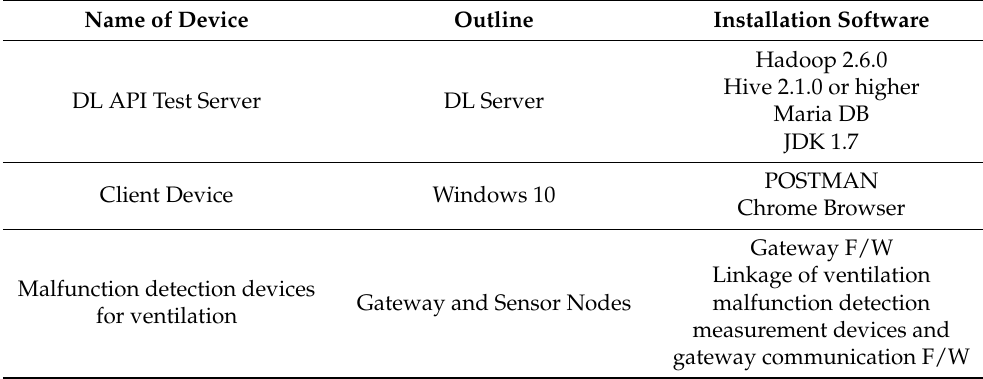
Table 14. Testing environment for the activation test of our proposed malfunction detection system for ventilation